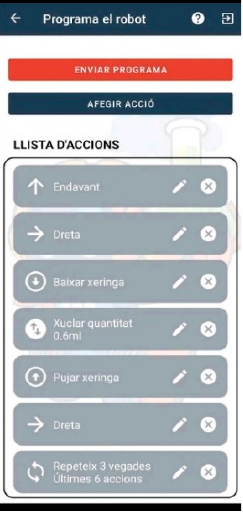
Figure 7. Interface for programming the Lab Qui-Bot and Lab2 Qui-Bot.